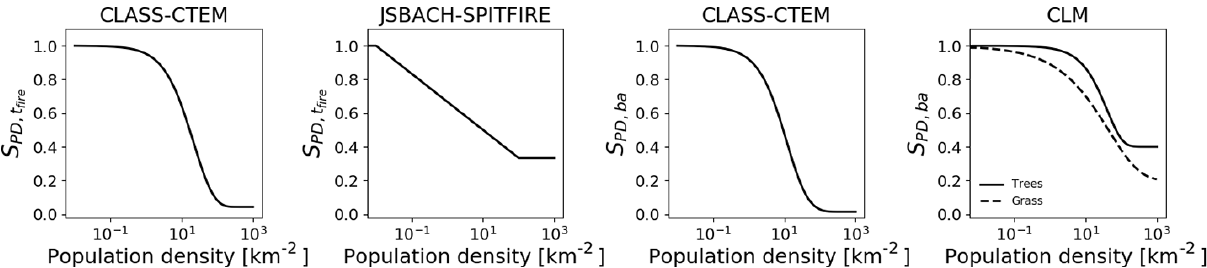
Figure 8. Suppression effects of population density on fire duration ( S PD ,t effects on fire size ( S PD , ba ) for CLASS-CTEM and CLM. All models are scaled to the value range